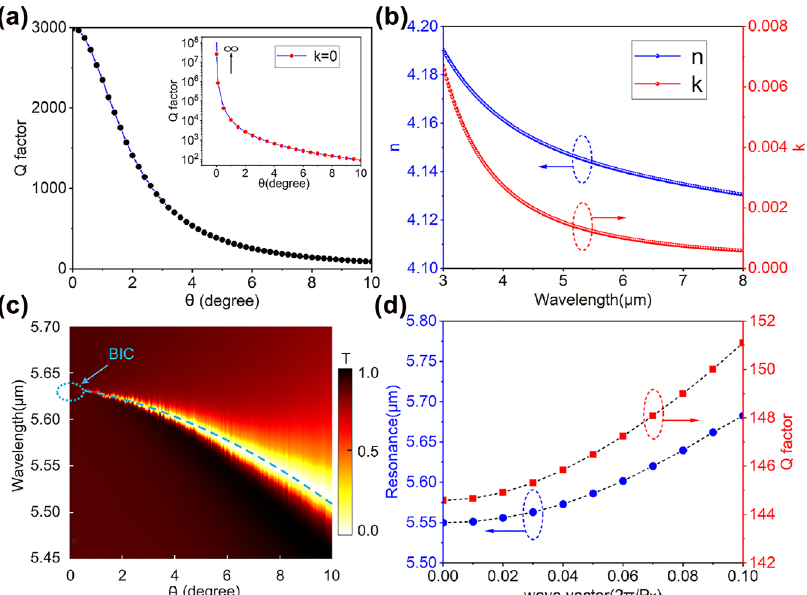
Figure 2: Numerical results of QBIC resonance properties. (a) Dependence of the Q factor of the QBIC resonance on the tilting angle between the elliptical disks. The black solid dots present the results when the material absorption of amorphous Ge (using the k value in Figure 2(b)) is considered, while the inset is for the case when Ge is assumed to be lossless. (b) The refractive index of the 300 nm Ge thin film measured by a MIR ellipsometer. (c) Simulated transmission spectrum as a function of 𝜃 , the blue dashed line representing QBIC dispersion, and the blue dashed circle marking the BIC mode at 𝜃 = 0. (d) The resonance frequency of the structure and the associated Q factor as a function of the transverse wave vector when 𝜃 = 8 ◦